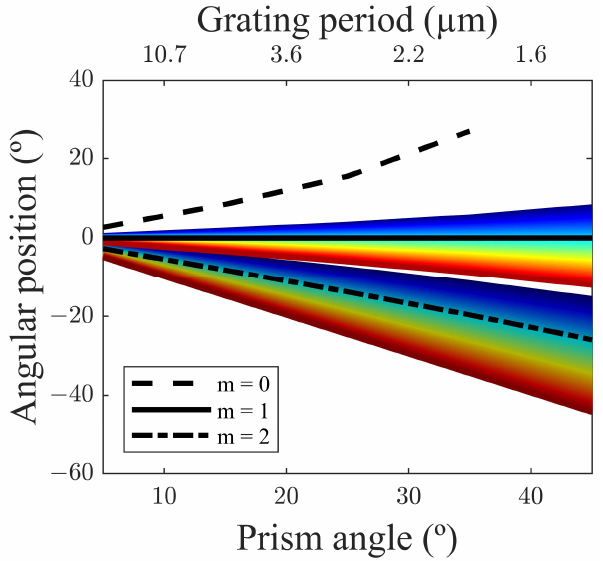
Figure 1. Angular position of m = 0, 1, 2 diffraction order as a function of the solution of Equation (1) for λ = 500 nm (black lines) and wavelengths in the VIS spectrum.